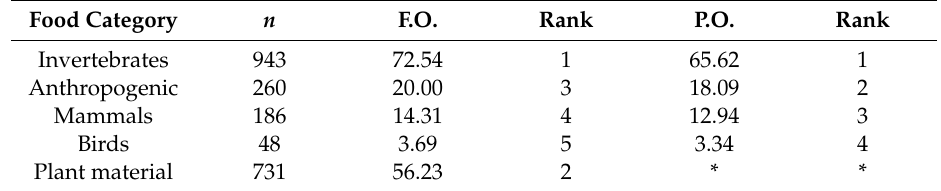
Table 1. Number of occurrences ( n ), frequency of occurrence (F.O.), percent occurrence (P.O.) and rank for each food category present in yellow mongoose scat ( n = 1300); rank 1 being the highest ranking and 5 being the